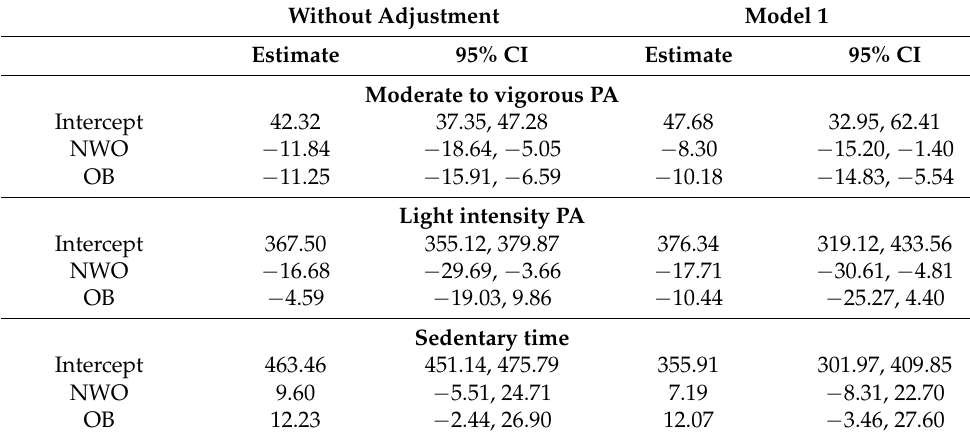
Table 2. Differences in physical activity and sedentary time (minutes per day) between the body composition